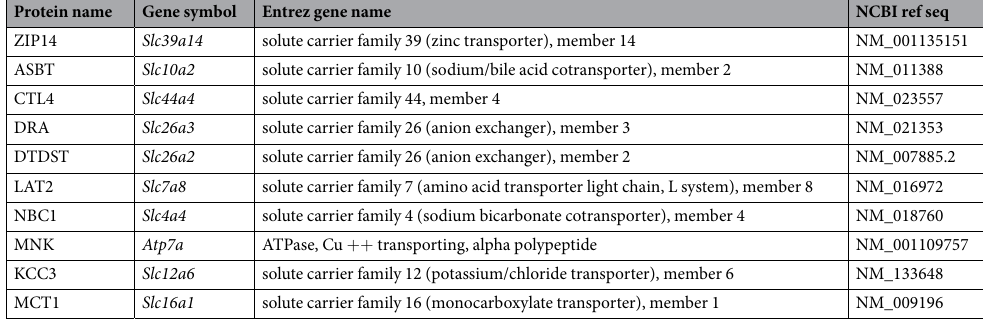
Table 2. EGCg transporter candidates identified by means of a shotgun proteomics